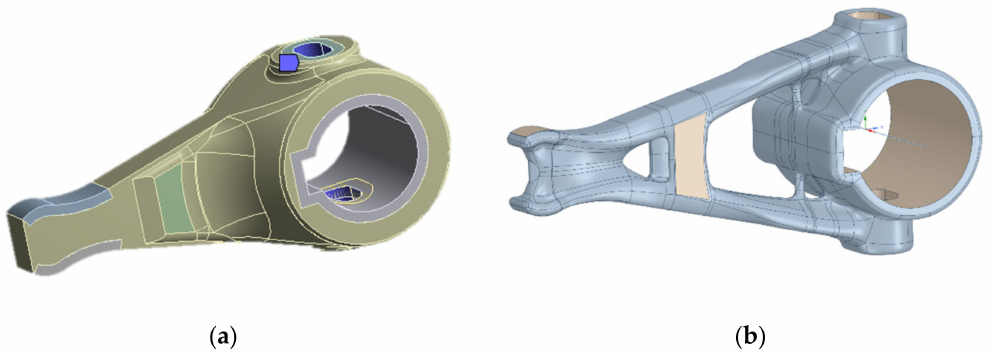
Figure 3. Original geometry of the main shifting thumb ( a ) and topologically smoothed shifting thumb ( b ).